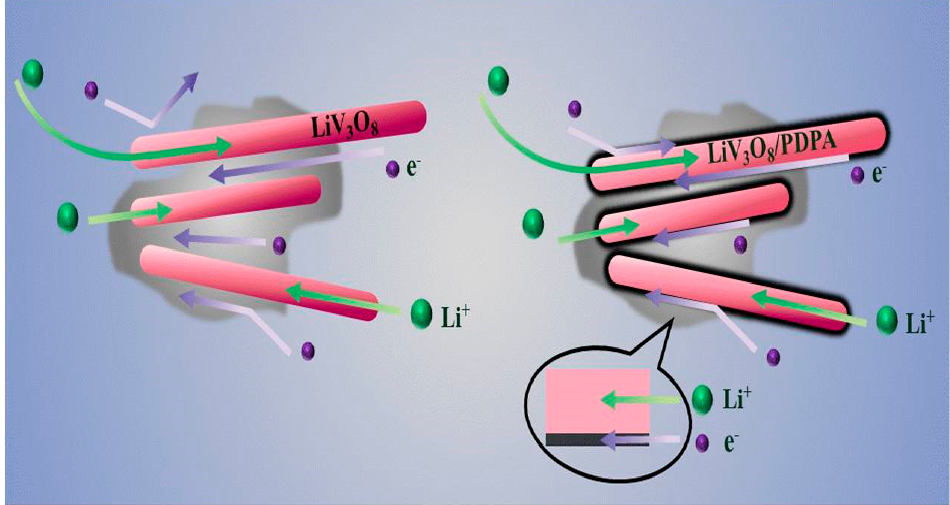
Figure 10. Schematic illustration of Li+ and electron transfer pathway for LVO and LVO/PDPA composites Reprint with permission [70] © 2018 American Chemical Society.